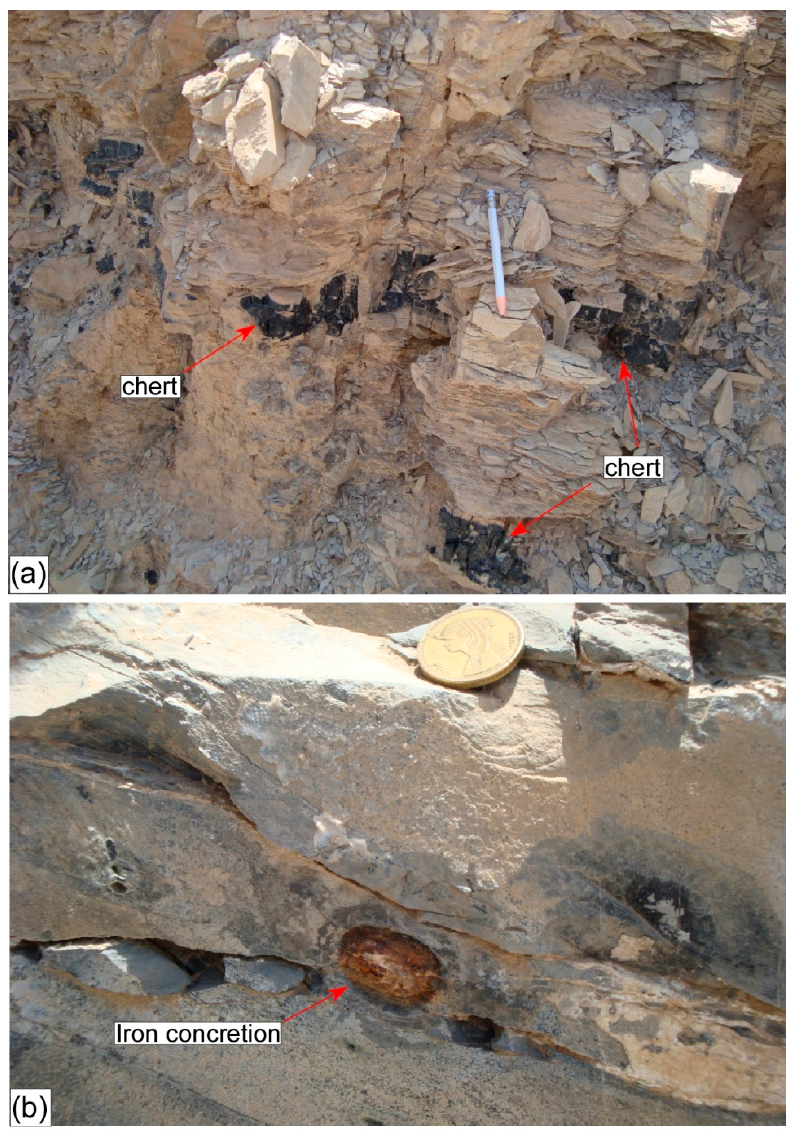
Figure 4. ( a ) Thinly laminated marly limestone with discontinuous chert bands. Pencil is 15 cm long. ( b ) Iron concretion developed along the bedding plane of black limestone in the baked zone. Coin diameter is 2 cm.